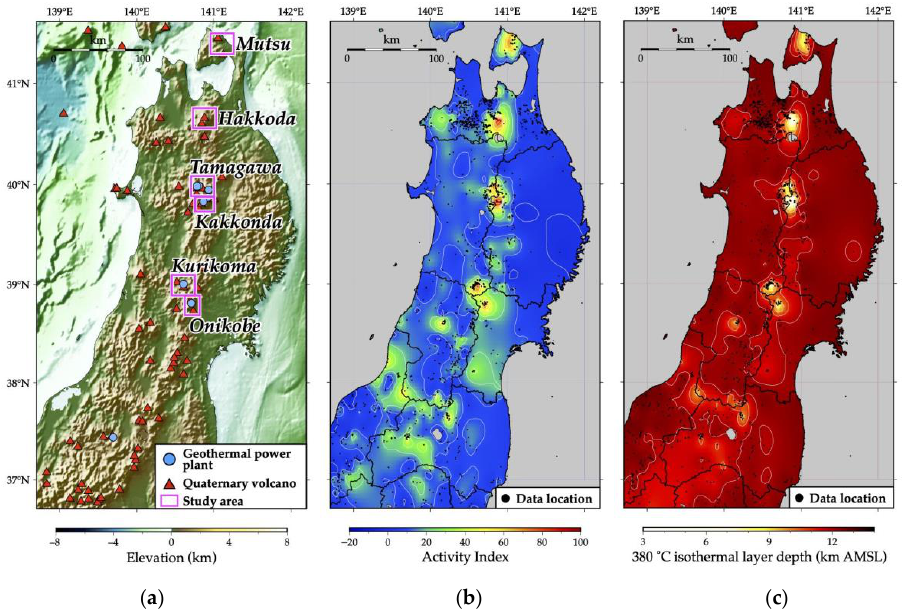
Figure 2. ( a ) Topographic map of northeastern Japan (SRTM30); ( b ) activity index distribution map of northeastern Japan; and ( c ) map showing the depth of the isotherm for 380 °C for northeastern Japan, estimated by the activity index.